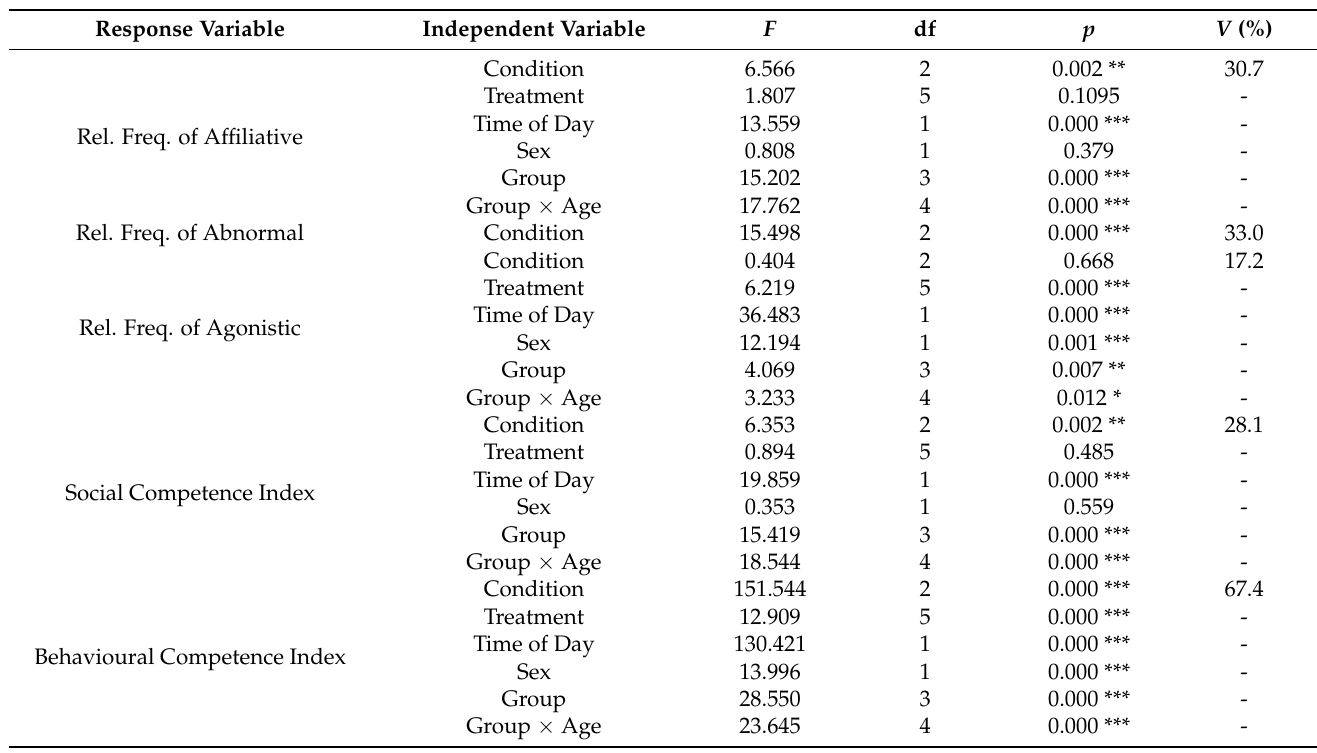
Table 4. Overall results of the linear mixed models for each response variable regarding the behaviour of the chimpanzees at Tacugama Chimpanzee Sanctuary (data collected from November 2019 until March